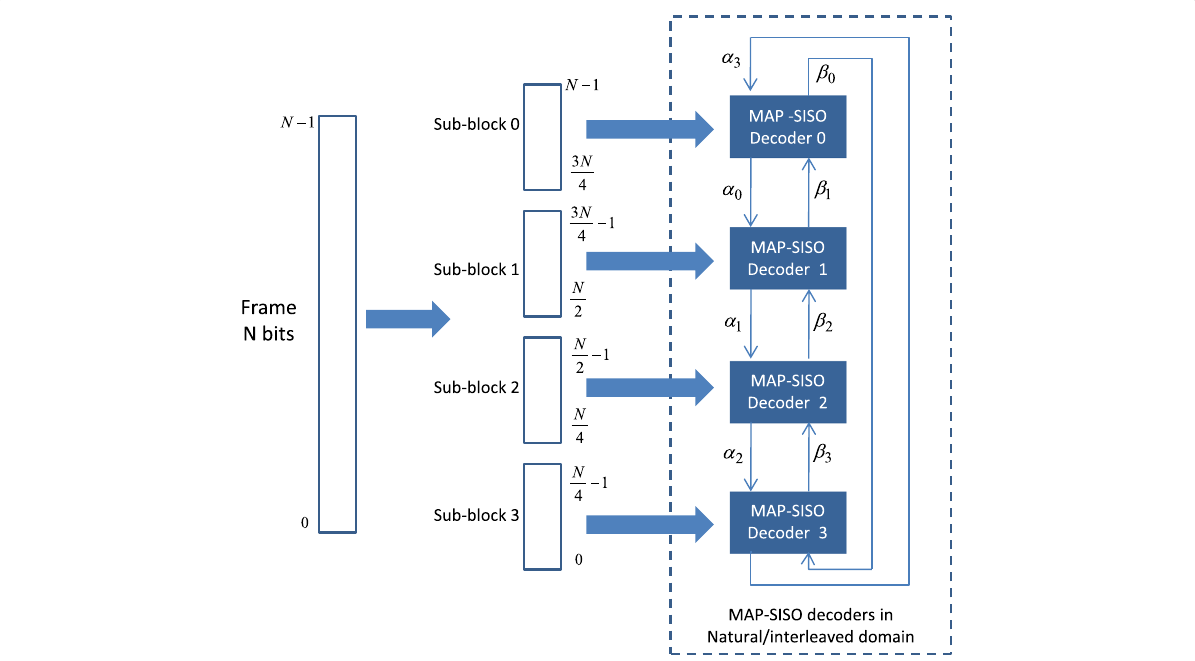
Fig. 3 Sub-block parallelism with message passing for recursion metric